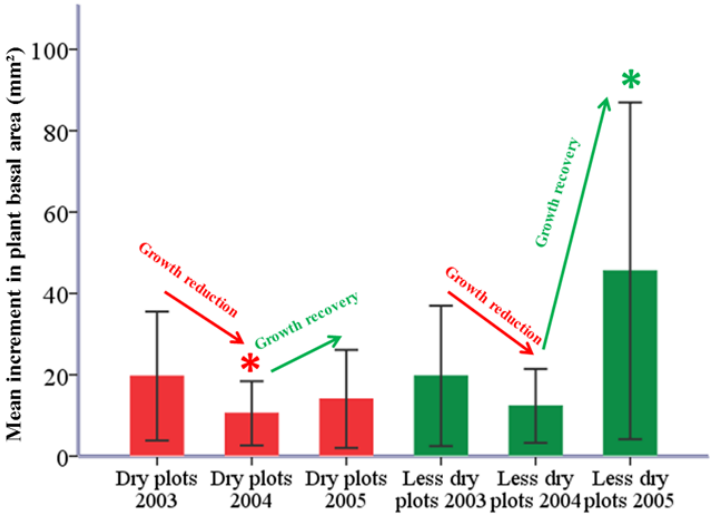
Figure 7. Comparisons of basal area increments between the years of 2003, 2004 and 2005 in dry (red) and less dry plots (green). Asterisks denote the level of significance ( p < 0.05). Thin bars indicate the standard error of mean at a 95% confidence